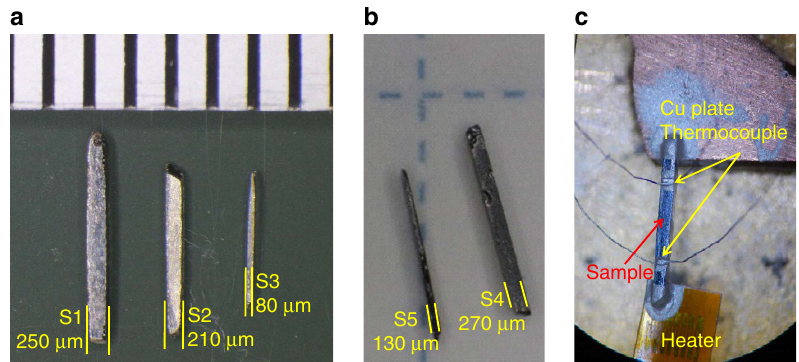
Figure 1 | Sample dimensions and setup for measuring the Seebeck coefficient and thermal conductivity. ( a ) Sample dimensions of S1, S2 and S3, which have cross-sections of 250 (cid:3) 245 m m 2 , 210 (cid:3) 205 m m 2 and 80 (cid:3) 160 m m 2 , respectively. ( b ) Two samples, S4 and S5, with cross-sections of 270 (cid:3) 250 m m 2 and 130 (cid:3) 150 m m 2 , respectively, are obtained by dividing a single crystal. ( c ) Measurement system for Seebeck coefficient S and thermal conductivity k . The sample is attached to the heater and Cu plate by silver paste (DuPont 4922N), with thermocouples on both ends. We measure the thermoelectric voltage of chromel-constantan thermocouples to evaluate the temperature difference and thermoelectric voltage of the sample using chromel